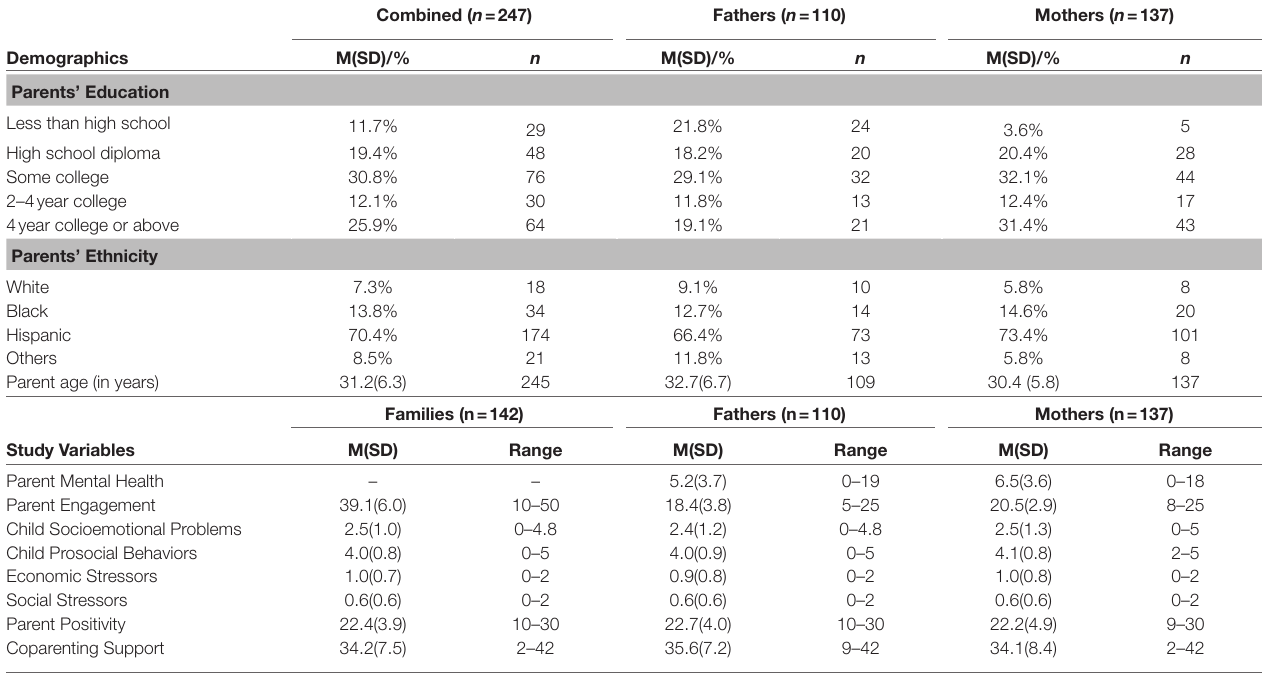
TABLE 1 | Sample Demographics and Descriptive Data by Families and Parent Gender.